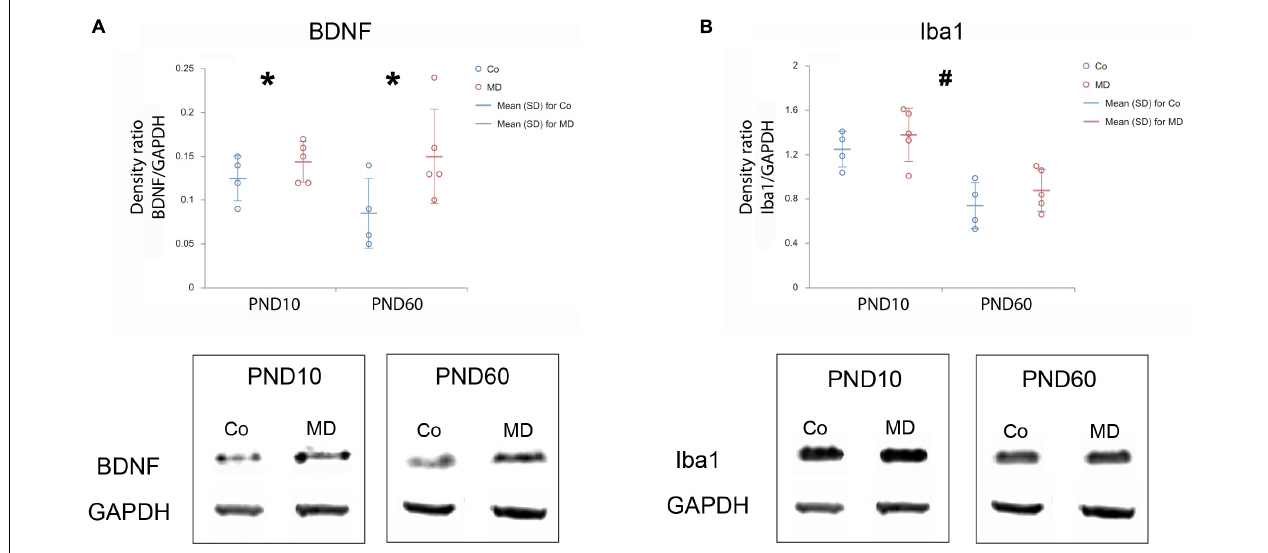
FIGURE 5 | Effects of MD on BDNF and Iba1 levels in PFC on PND10 and PND60. Dot plot graphs represent the expression of BDNF (A) and Iba1 (B) relative to GAPDH as means ± SD (horizontal bars) and observed values (dots), n = 4 for Co, n = 5 for MD for each developmental stage. Figures are accompanied by representative immunoblots. Loading control protein (GAPDH) is re-used for illustrative purposes in (A,B) . MD increased BDNF expression in PFC irrespective of age (A) , while a decrease in Iba1 expression was found for PND60 animals irrespective of MD (B) . *p = 0.001 Co vs. MD irrespective of age, # p < 0.001 PND10 vs. PND60 irrespective of treatment. Co control, MD maternally deprived